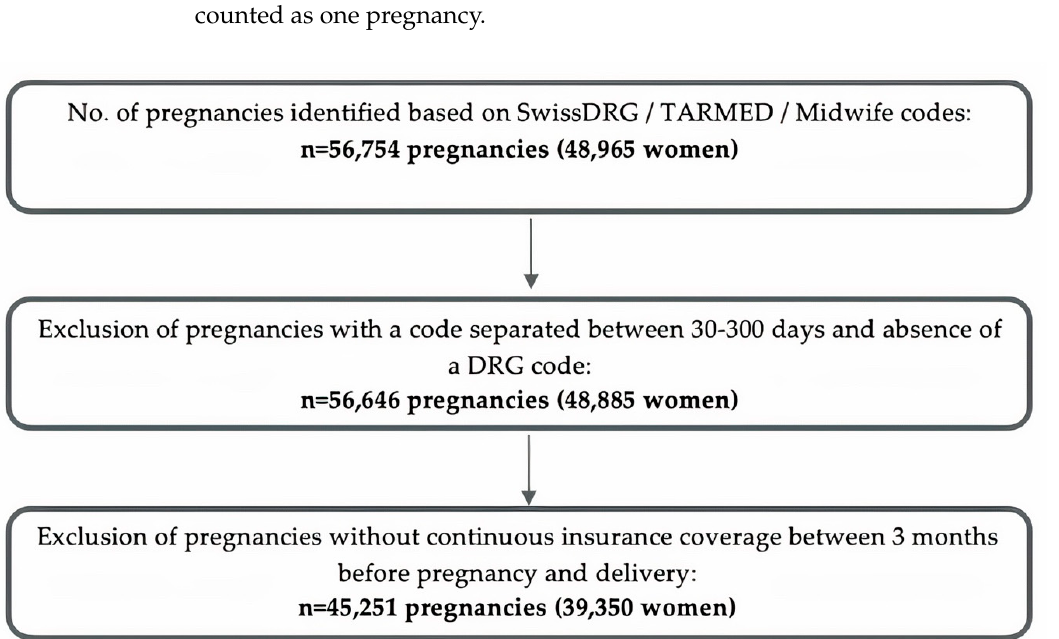
Figure 1. Flowchart of unweighted study population.